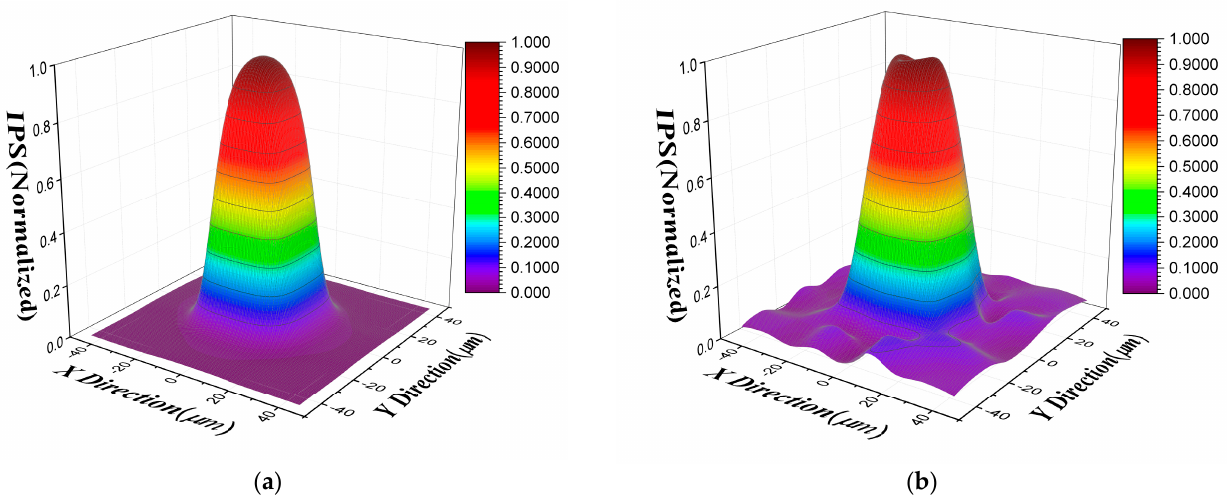
Figure 7. Calculated IPS of target pixel in the short-wave infrared FPA photodetector: ( a ) calculated IPS based on the DCP model; ( b ) calculated IPS based on the DSPR model.